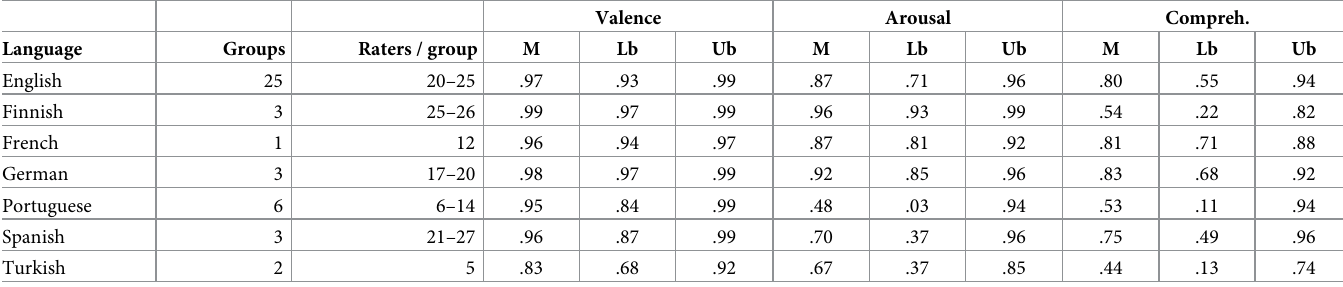
Table 3. Reliability of valence, arousal, and comprehensibility ratings for English texts and the texts in their original language as averages of ICC(2,k). Valence Arousal